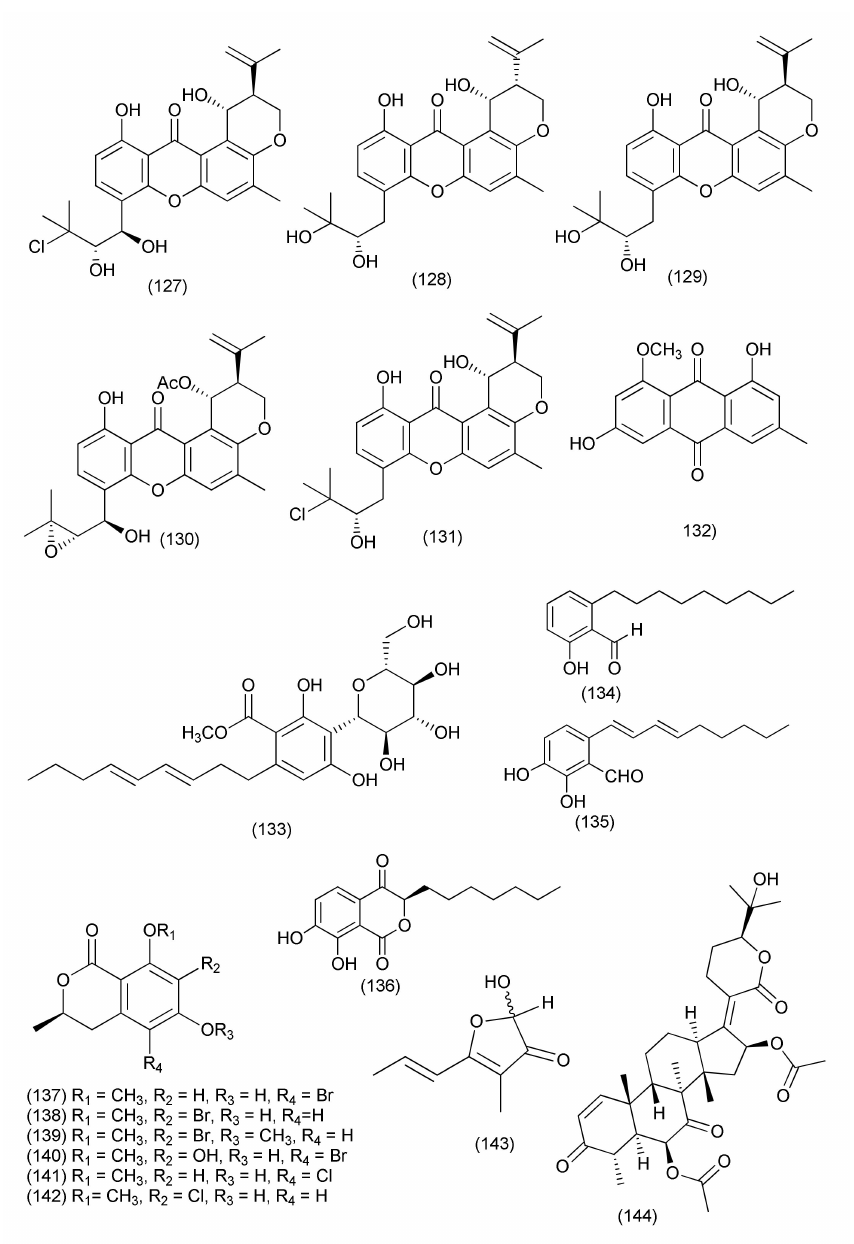
Figure 8. Structures of metabolites 127 – 144 isolated from